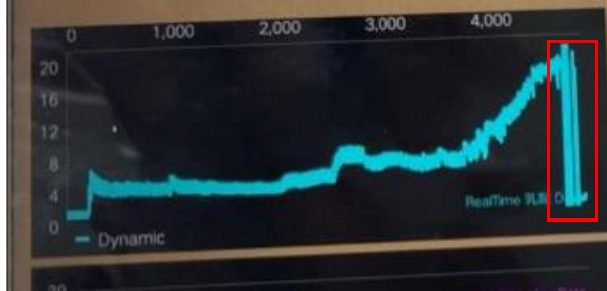
Figure 17. Sweat-affected data.